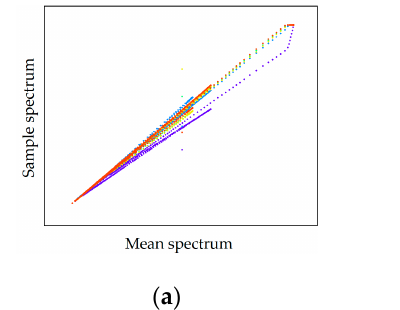
Table 1. PLS results of process analytical technology (PAT) feasibility study for Raman and DAD referring to mAb concentration and purity.